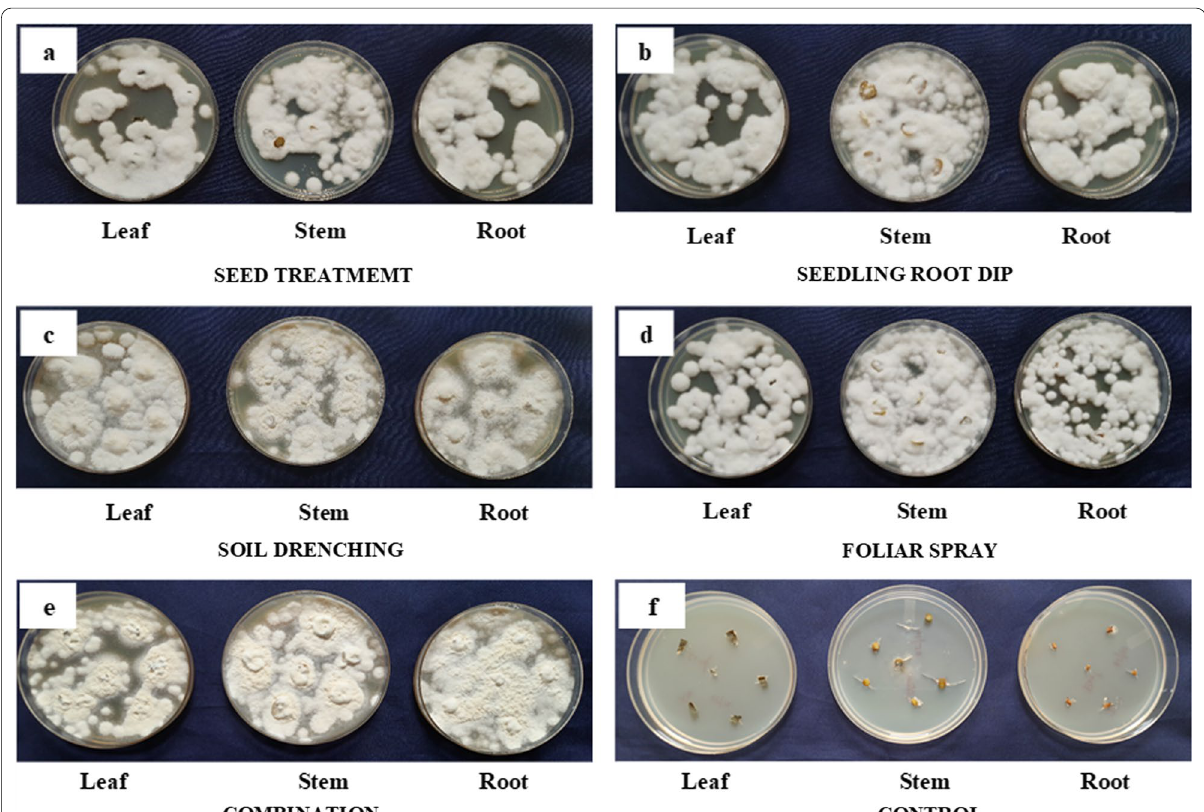
Fig. 3 Recovery of indigenous endophytic, Beauveria bassiana UHSB-END1 from tissues (leaf, stem and root) of tomato showing colony growth at different treatments: seed treatment ( a ), seedling root dip ( b ), soil drenching ( c ), foliar spray ( d ), combination of seed treatment, seedling root dip and foliar spray e at 40 dpi as compared to control ( f